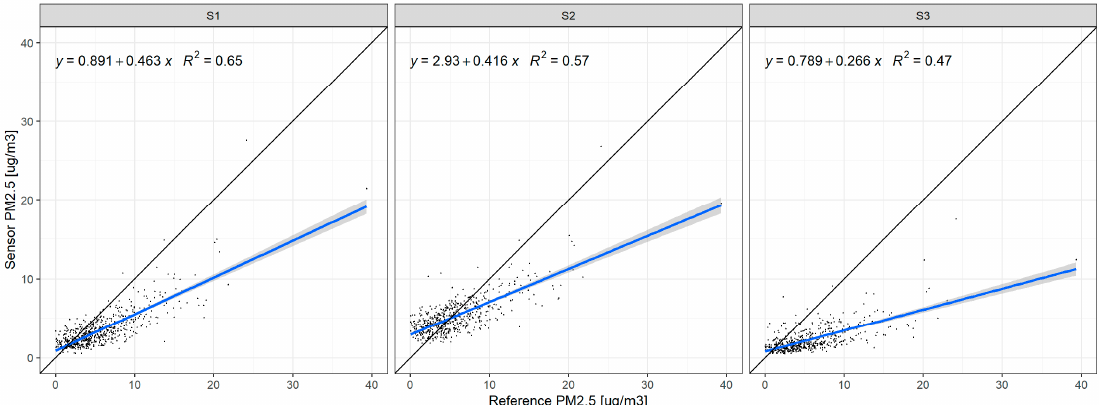
Figure 11. Linear regression for 1-hour average PM 2.5 values for environmental condition with RH < 70% from the three SDS011 sensors versus the PM 2.5 data from the air quality monitoring station for the entire study